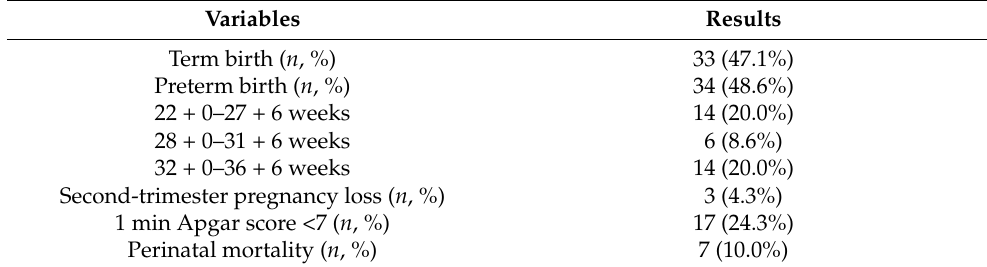
Table 3. The pregnancy outcomes in the study